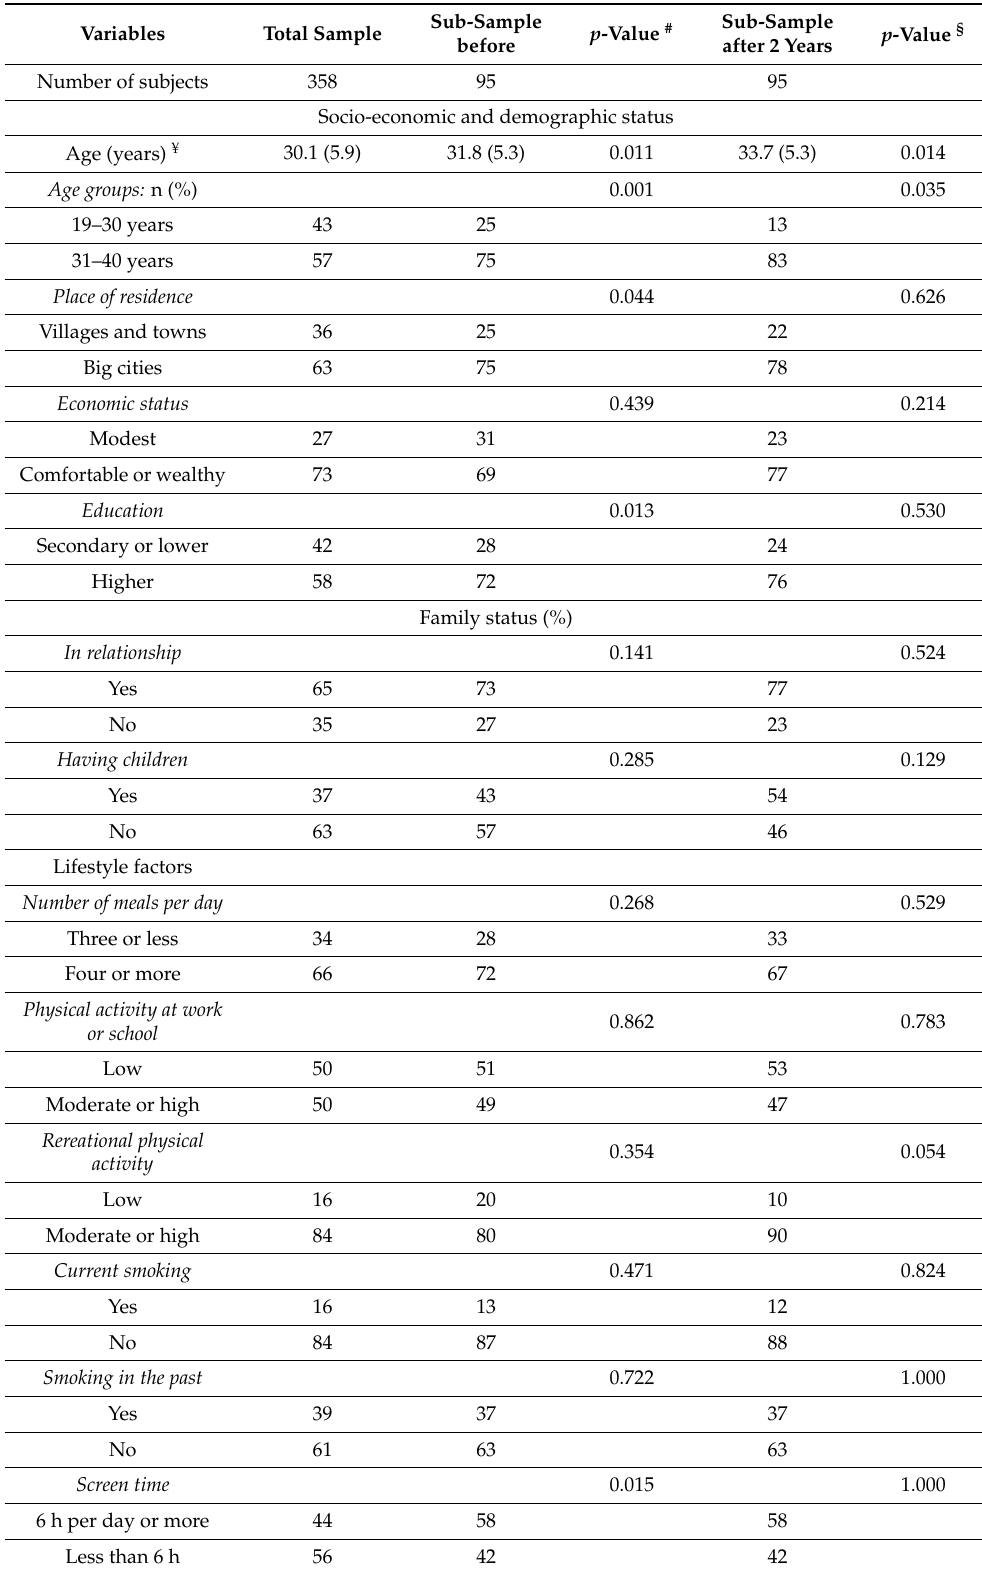
Table 1. Total sample and sub-sample characteristic: family socio-economic, demographic status lifestyle factors, diet, adiposity and metabolic outcomes in total sample and sub-sample (means and SD or number of subjects and % of the